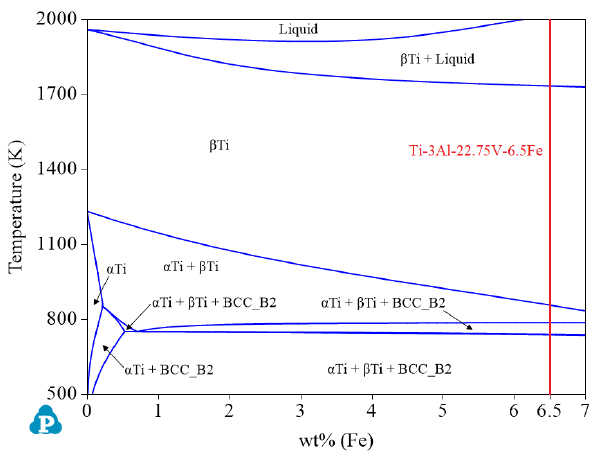
Figure 10. The calculated pseudo-binary section of V:Fe = 3.5:1 and 3.0 wt% Al.